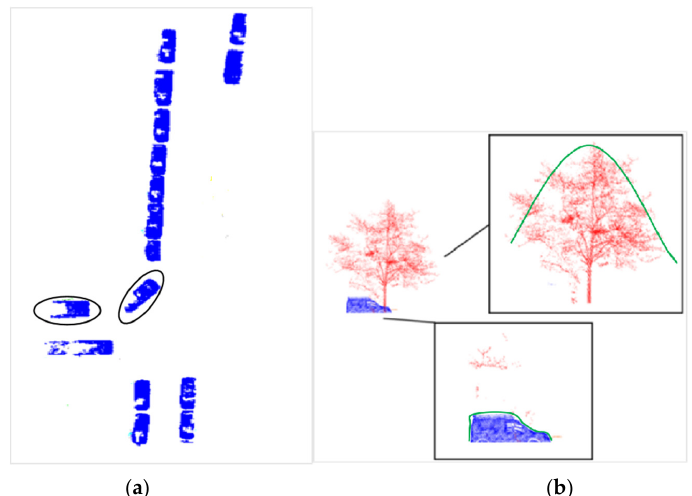
Figure 23. Vehicle recognition advantage of the proposed method in two limitation situations. Note: the recognition result of the moving vehicles by the proposed method ( a ); the separation between the vehicles and trees that overlap in the Z direction ( b ) (vehicles in dark blue, trees in